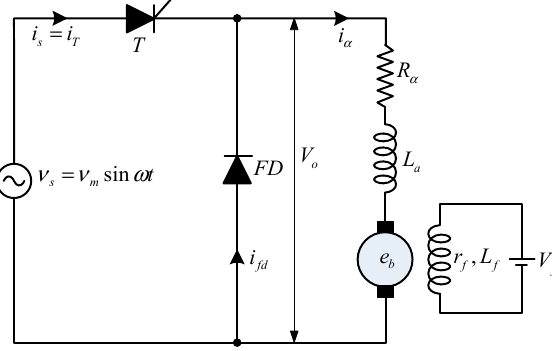
Figure 4. Single-phase half wave converter drive.